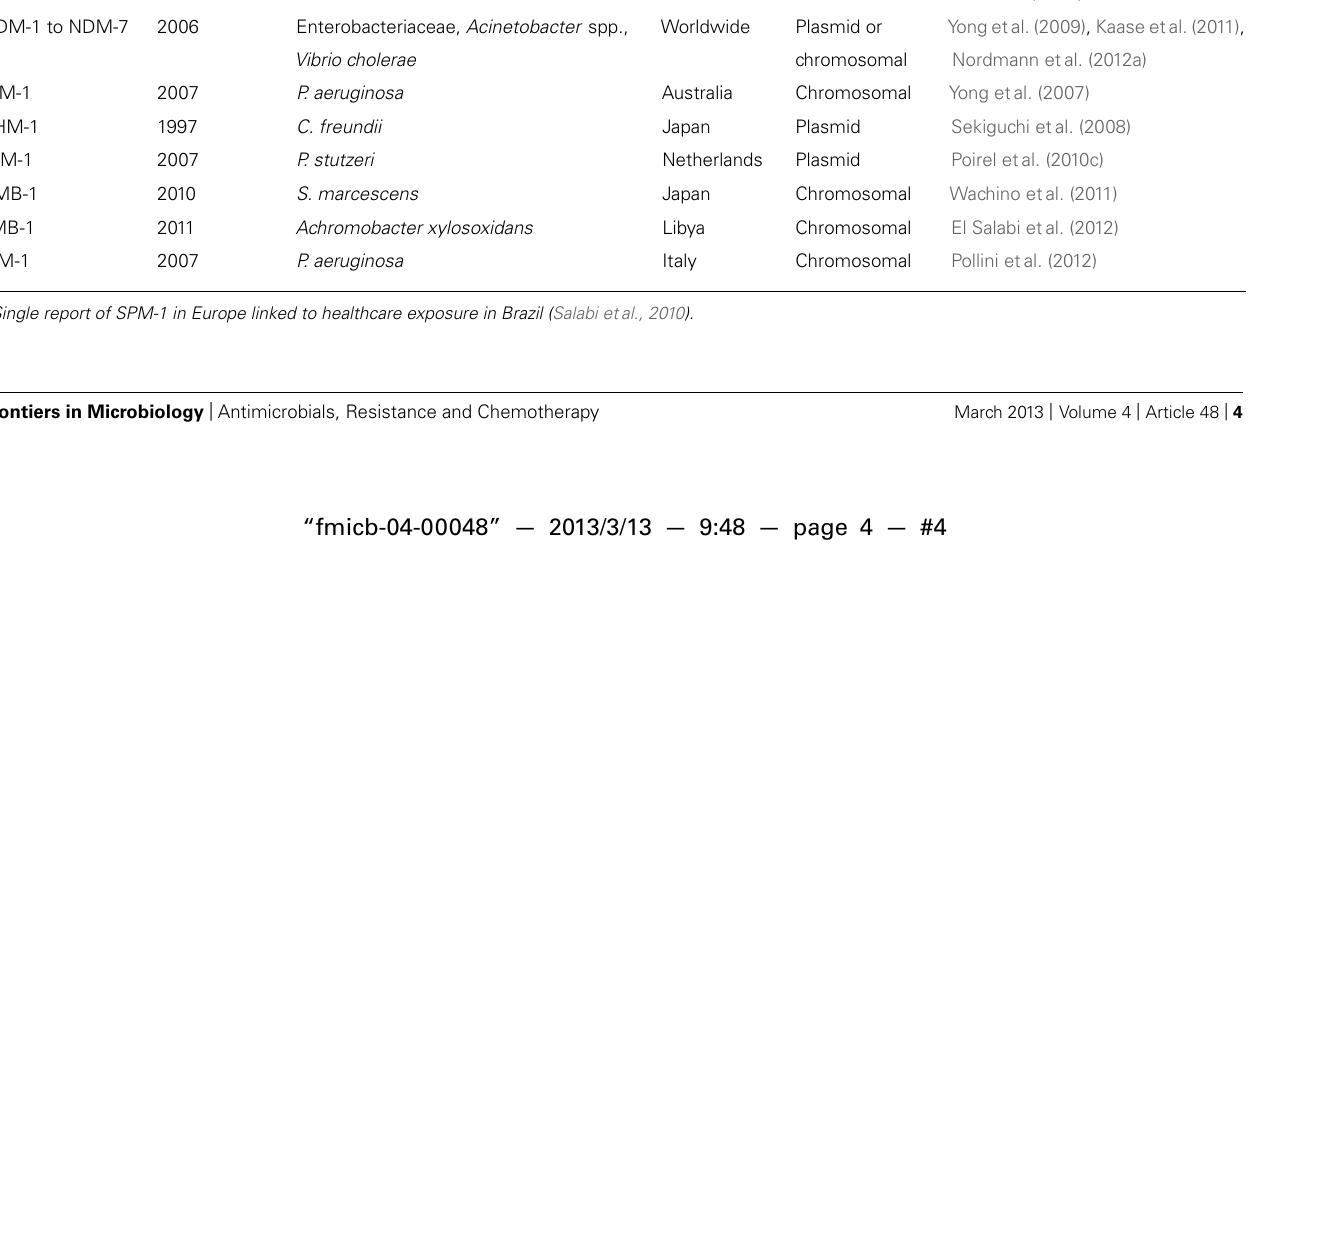
Frontiers in Microbiology | Antimicrobials, Resistance and